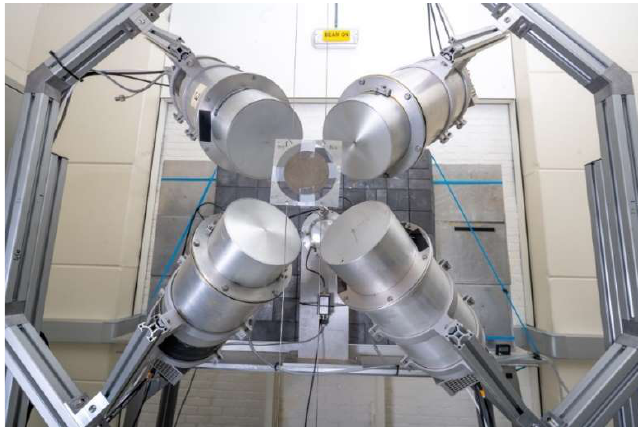
Fig. 1. Neutron capture setup based on C 6 D 6 detectors located at GELINA FP14-60m measurement